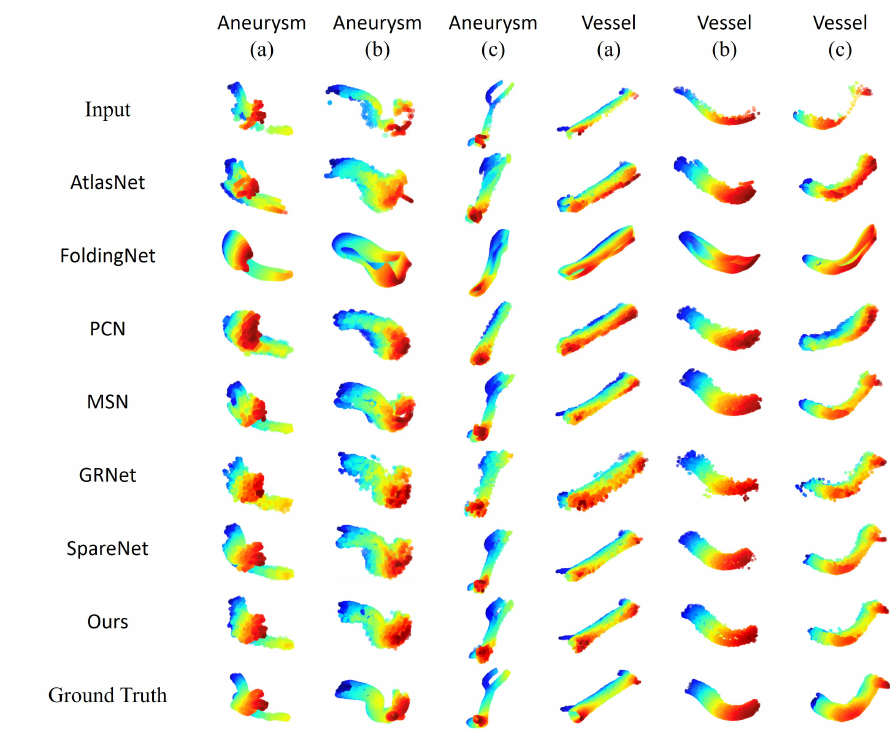
Figure 10. Visual comparison of point cloud completion on the IntrACompletion dataset.